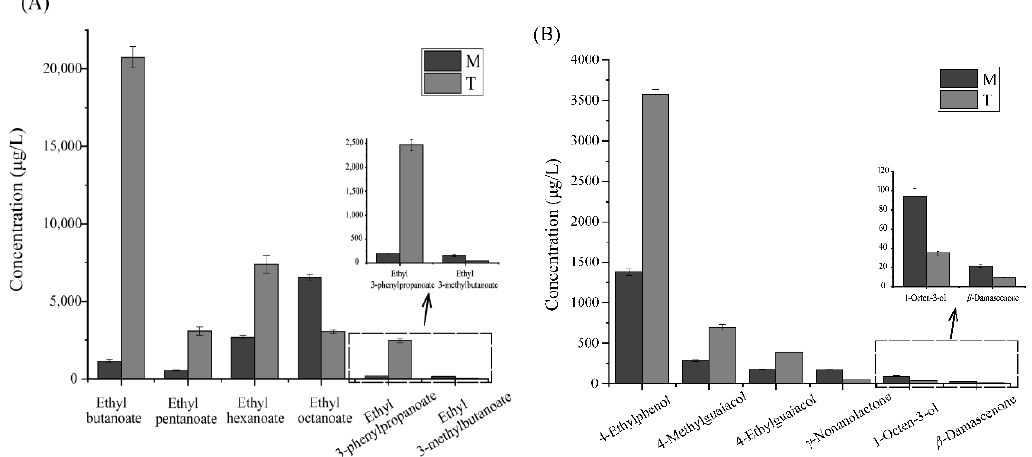
Figure 2. Concentrations of some different aroma-active compounds in M and T samples. In the Figure 2, ( A ) is the concentration difference between ester compounds, and ( B ) is the concentration difference between others.